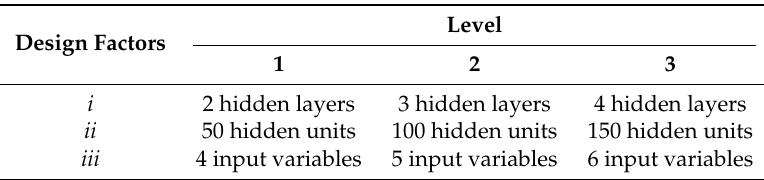
Table 1. Design factors and their corresponding